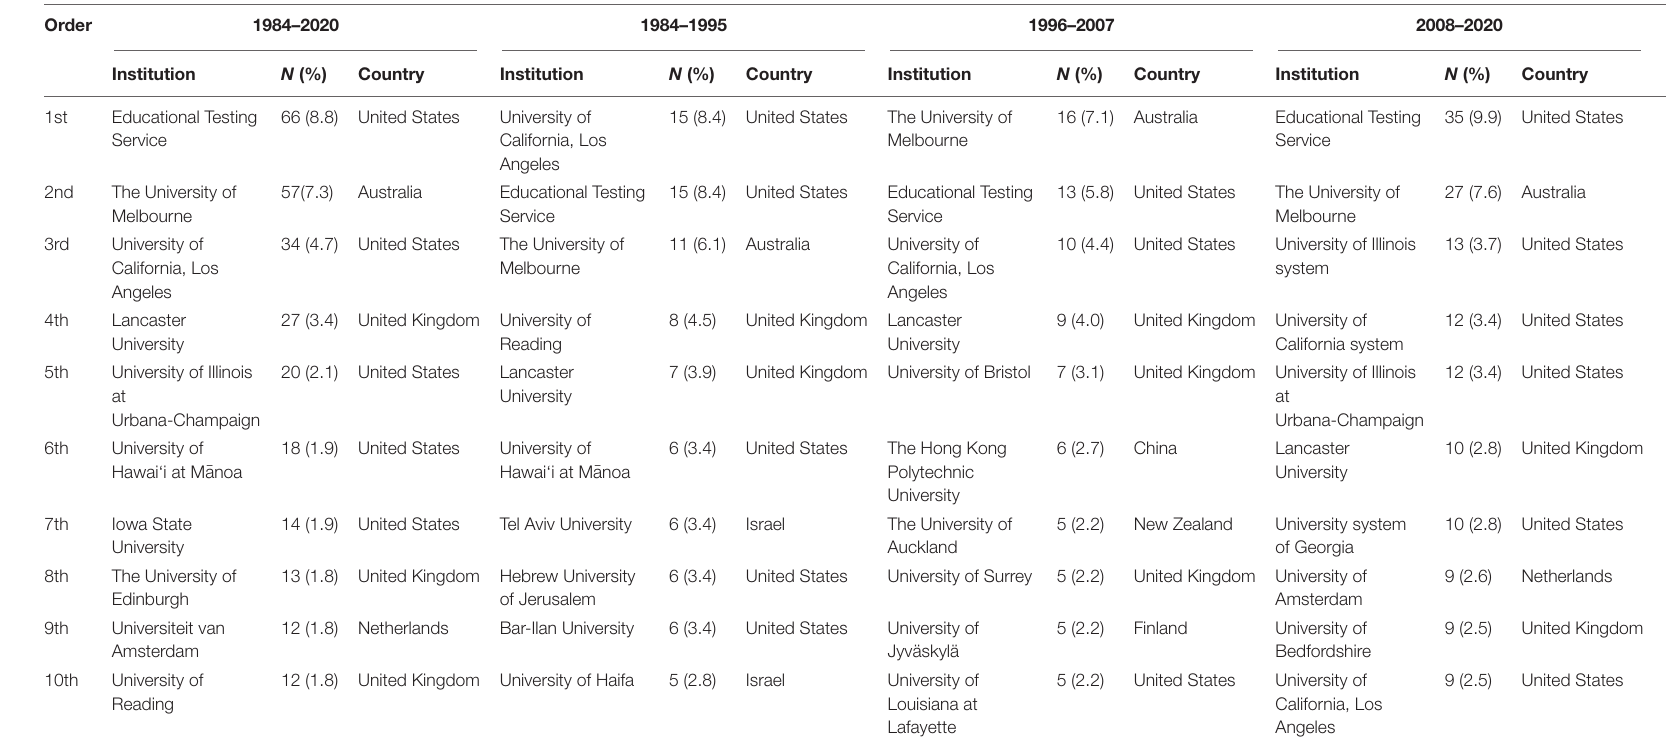
TABLE 7 | Top 10 most productive institutions.